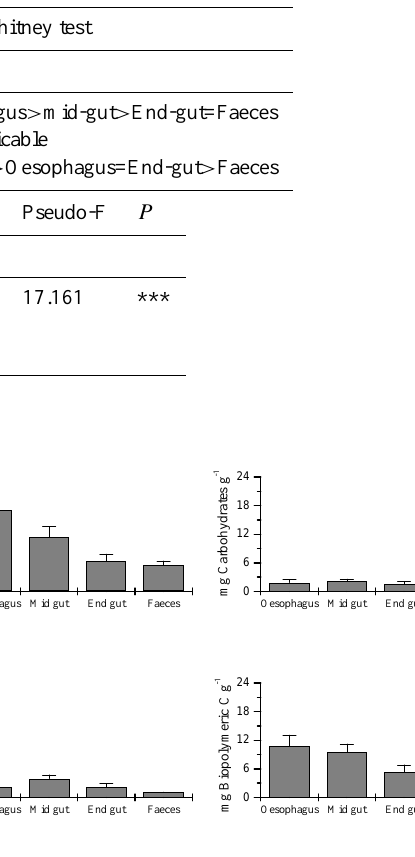
Fig. 4. Distributions of the main biochemical classes of organic compounds (proteins, carbohydrates, lipids) and biopolymeric C through the gut of M. musculus (oesophagus, mid gut, hind gut and faeces). Standard deviations are indicated. Data are expressed in milligrams per g of sediment dry weight ( n =